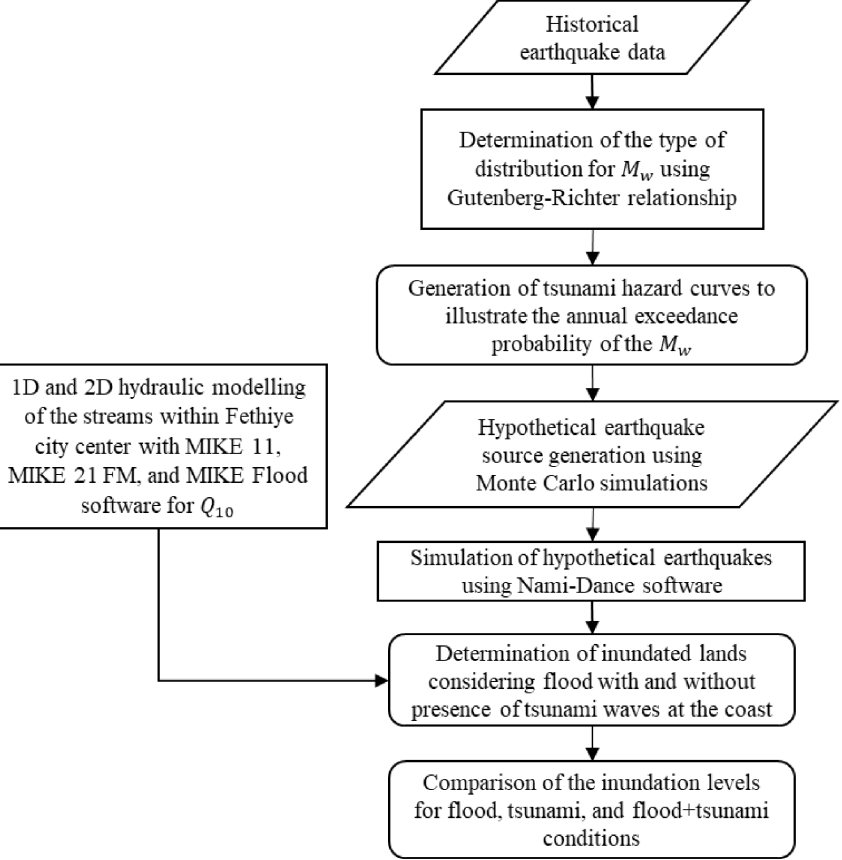
Figure 2. Multi-hazard assessment framework used in this study.